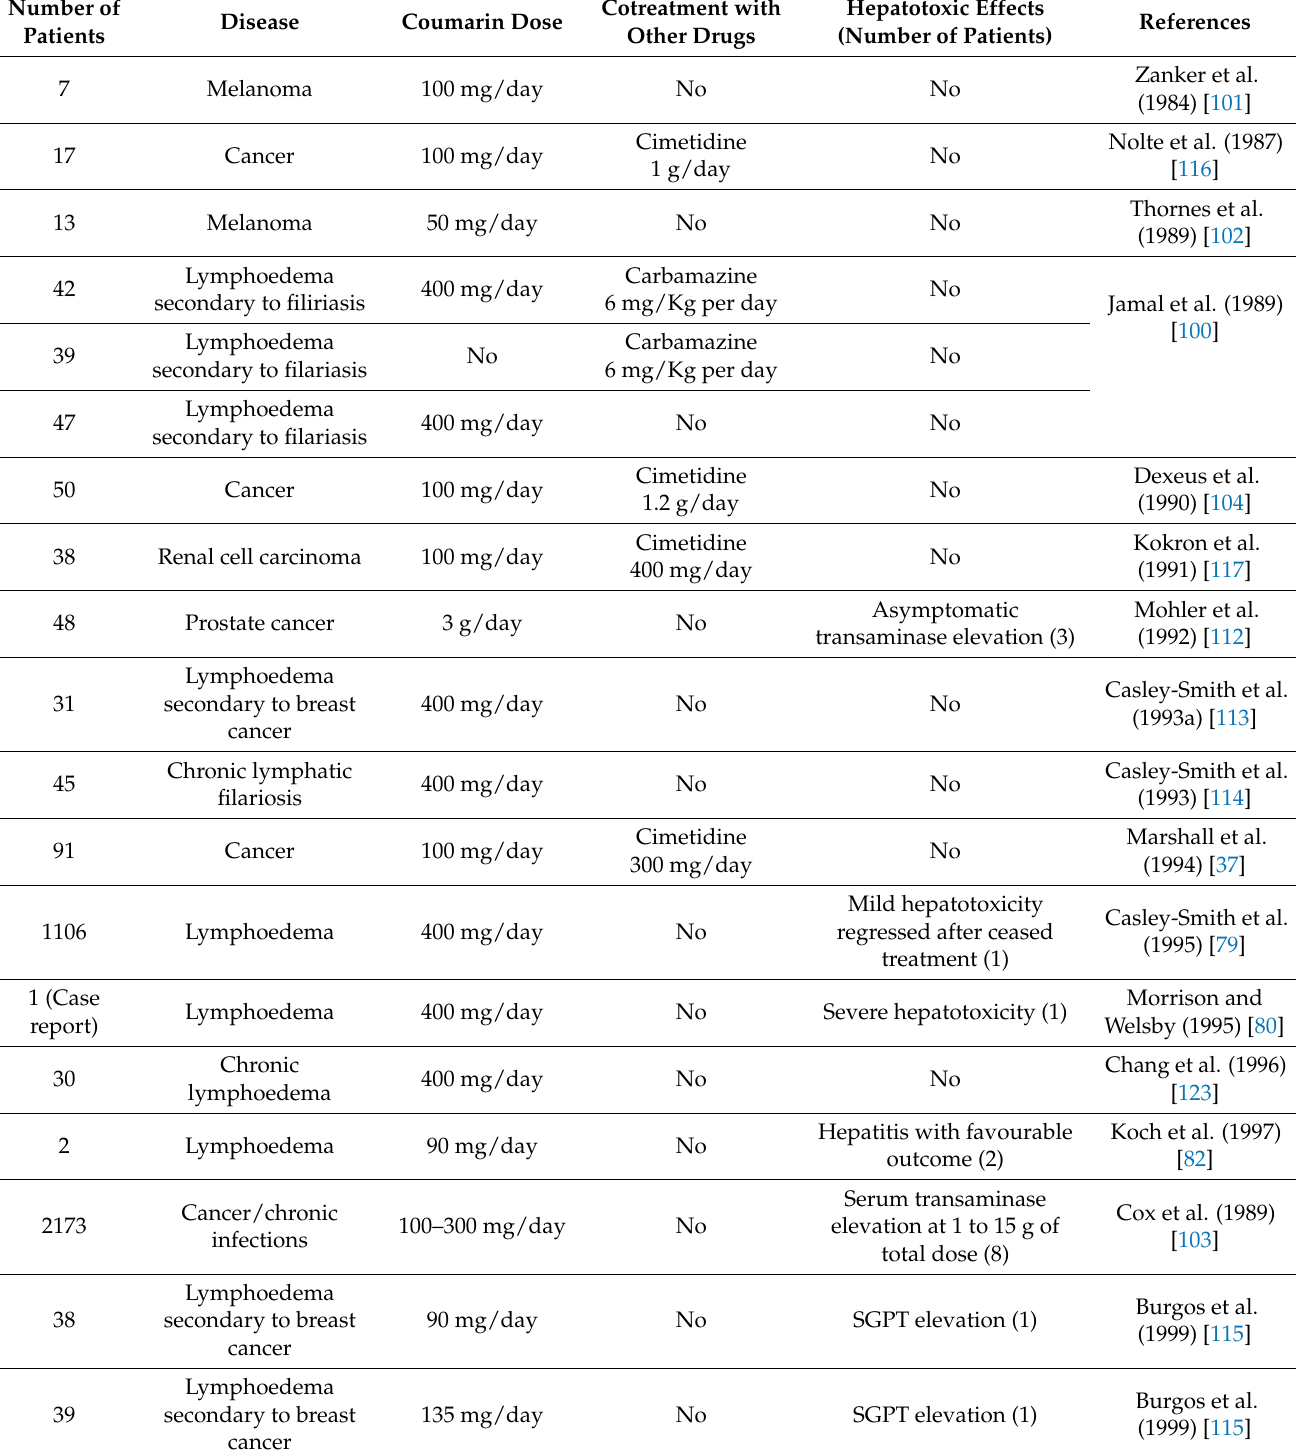
Table 1. Coumarin safety and tolerability in clinical